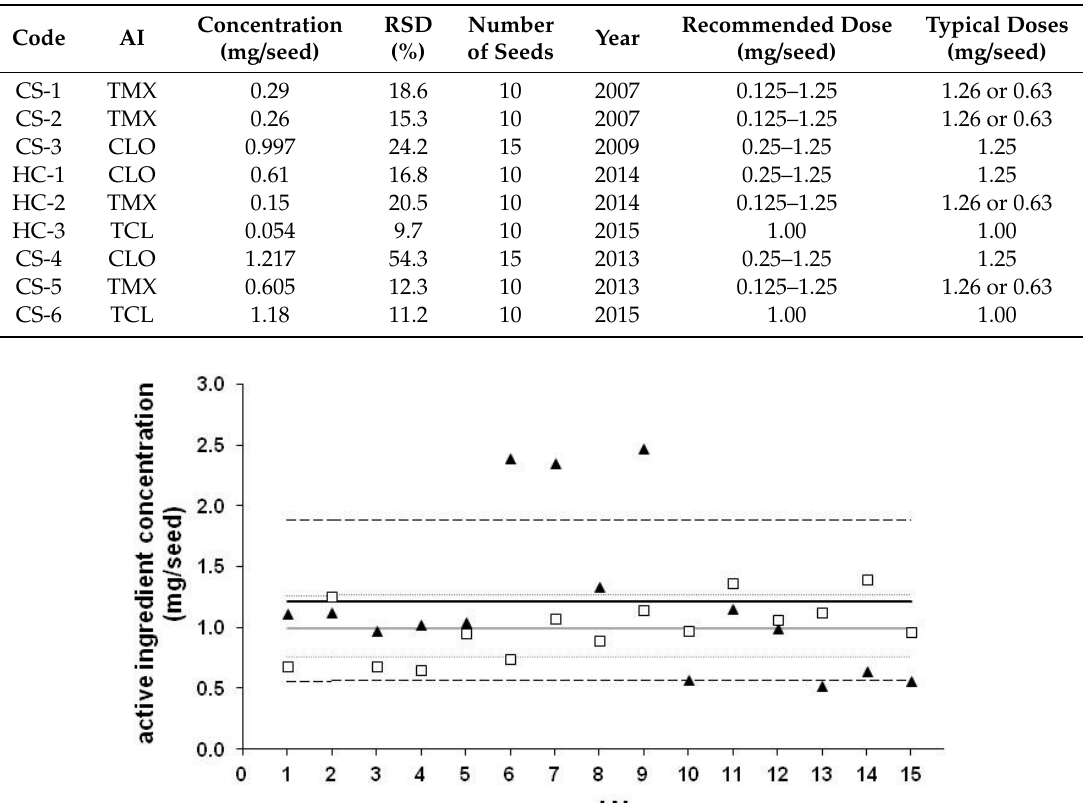
Table 1. The concentration of neonicotinoid active ingredients (AIs) in seed coating of maize seeds.